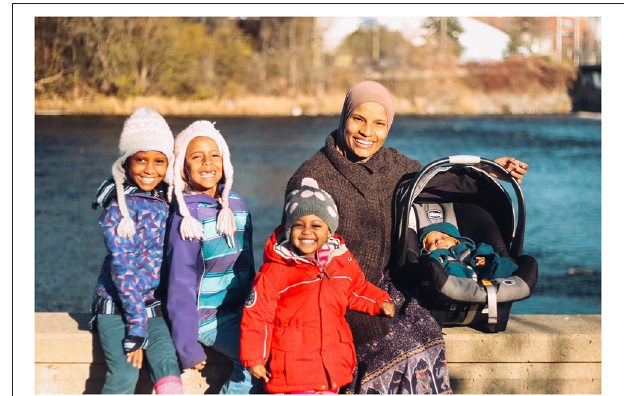
FIGURE 4 | Candace and her family after crossing over the hospital Red Sea of tape. Photo by Kamal Abdulhakim. Used with